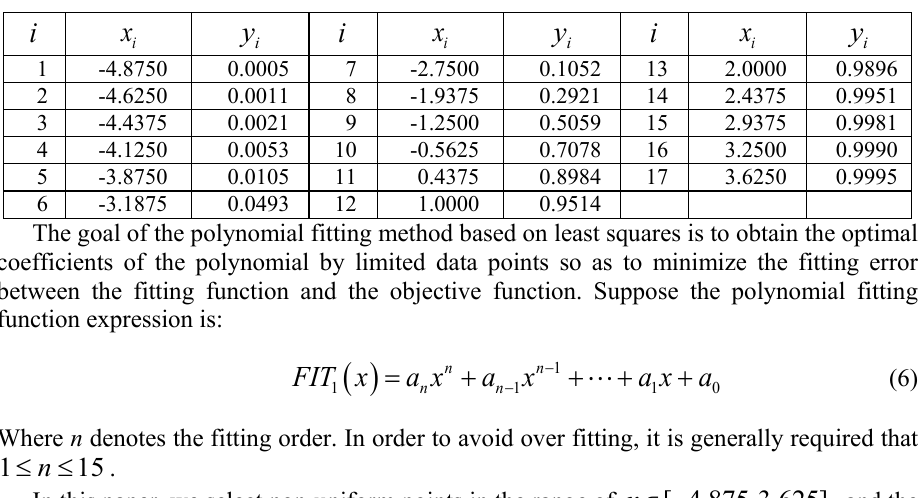
Table 1. Data points for fitting the CDF of first-order Tracy-Widom